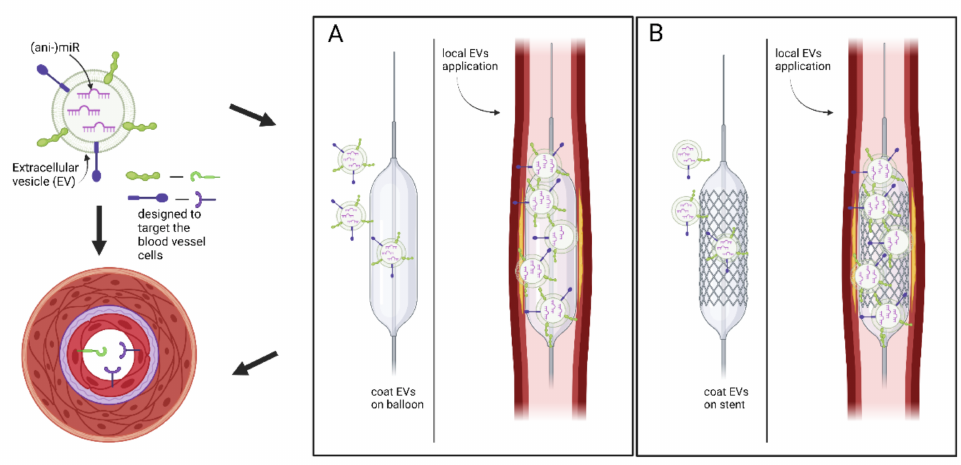
Figure 3. Potential therapeutic approaches based on miR perturbation in human coronary arteries. Coating of drug-eluting balloons ( A ) or stents ( B ) (similarly as proposed by Hu et al. [55]) with extracellular vesicles carrying miR, miR-mimics or anti-miRs has the potential to target specific cell types relevant for atherosclerosis in affected coronary arteries. Besides being inside EVs or conjugated to (lipo)proteins make extracellular miRNAs resistant to